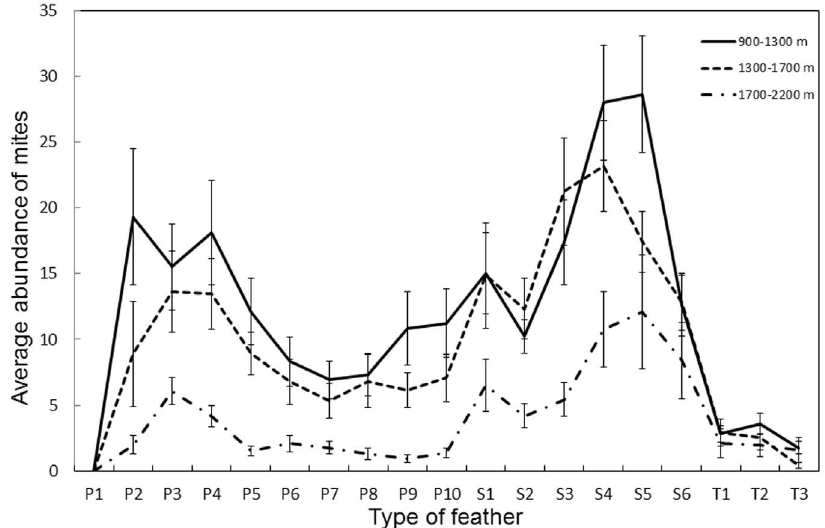
Figure 5. Wing distribution of feather mites along elevation. Average intensity ( 6 SE) of mites per feather (primaries: P1–P10, secondaries: S1–S6 and tertiaries: T1–T3) in three altitudinal